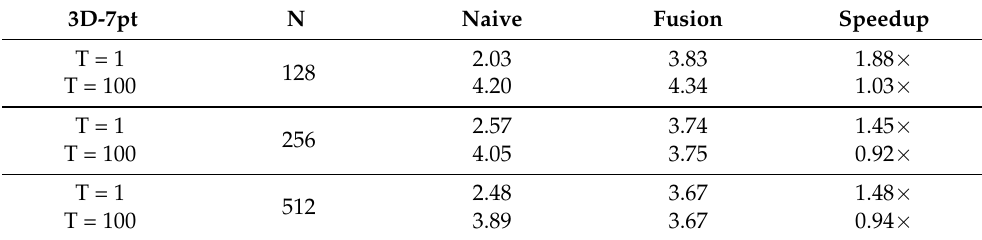
Table 4. Experimental results of the proposed transformation recipes: (f) loop fusion